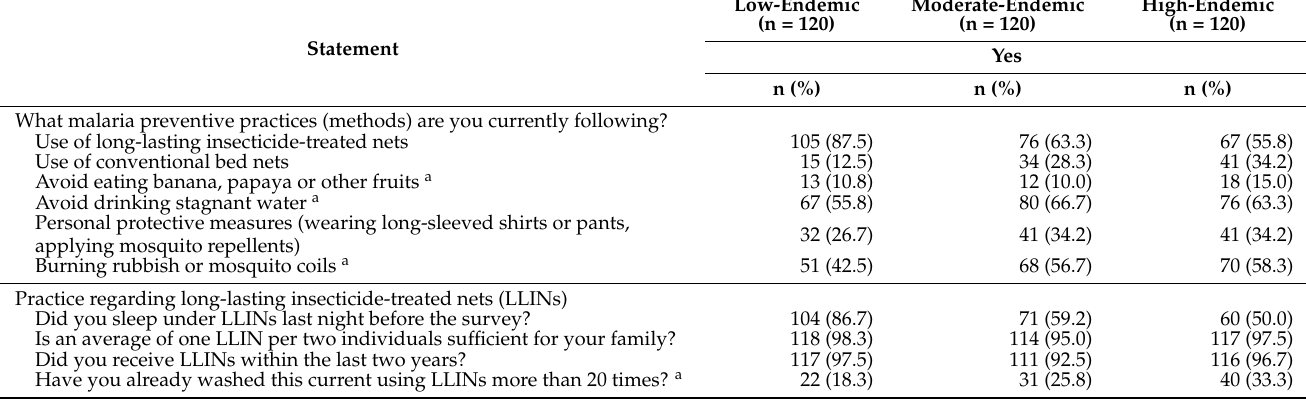
Table 3. Malaria preventive practices among respondents from each malaria-endemic